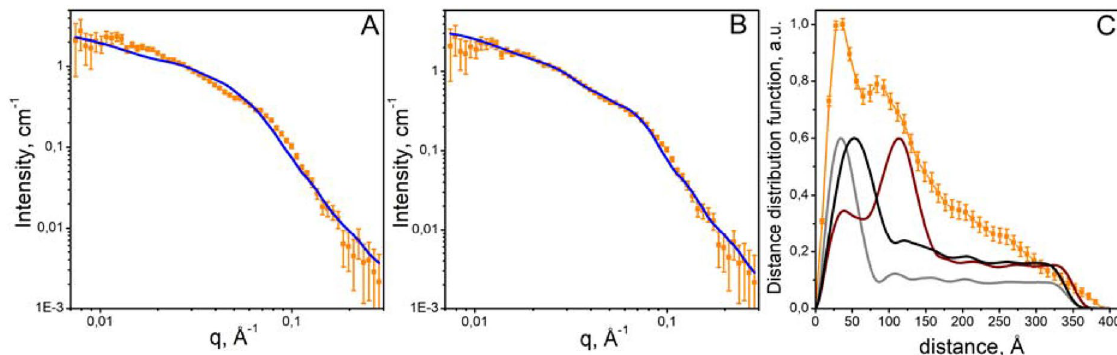
Figure 3. SANS curve for Np SRII/ Np HtrII at 4.0 M NaCl and corresponding distance distribution functions. ( A ) Experimental scattering curve for Np SRII/ Np HtrII at 4.0 M NaCl (orange squares) fitted with χ 2 = 5.5 to a theoretical curve (blue line) calculated for a mixture of Np SRII/ Np HtrII dimers and trimers of dimers which inter-dimer contacts are induced both between the transmembrane regions of dimers and their cytoplasmic tips (Fig. 4A). ( B ) Experimental scattering curve for Np SRII/ Np HtrII at 4.0 M NaCl (orange squares) fitted with χ 2 = 1.3 to a theoretical curve (blue line) calculated for a mixture of Np SRII/ Np HtrII dimers and "tripod"-shaped trimers of dimers (Fig. 4B). ( C ) Distance distribution function calculated from the experimental curve shown in ( A , B ) (orange squares), and theoretical distance distribution functions of the dimers (grey line), the "tripod"- shaped (Fig. 4B) trimers of dimers (brown line) and the "transmembrane-bound" conformation of trimer of dimers of the Np SRII/ Np HtrII (Fig. 4A) (black line). For greater clarity, distance distribution functions were normalized to obtain maximum values of 1.0 for the experimental and 0.6 for the theoretical